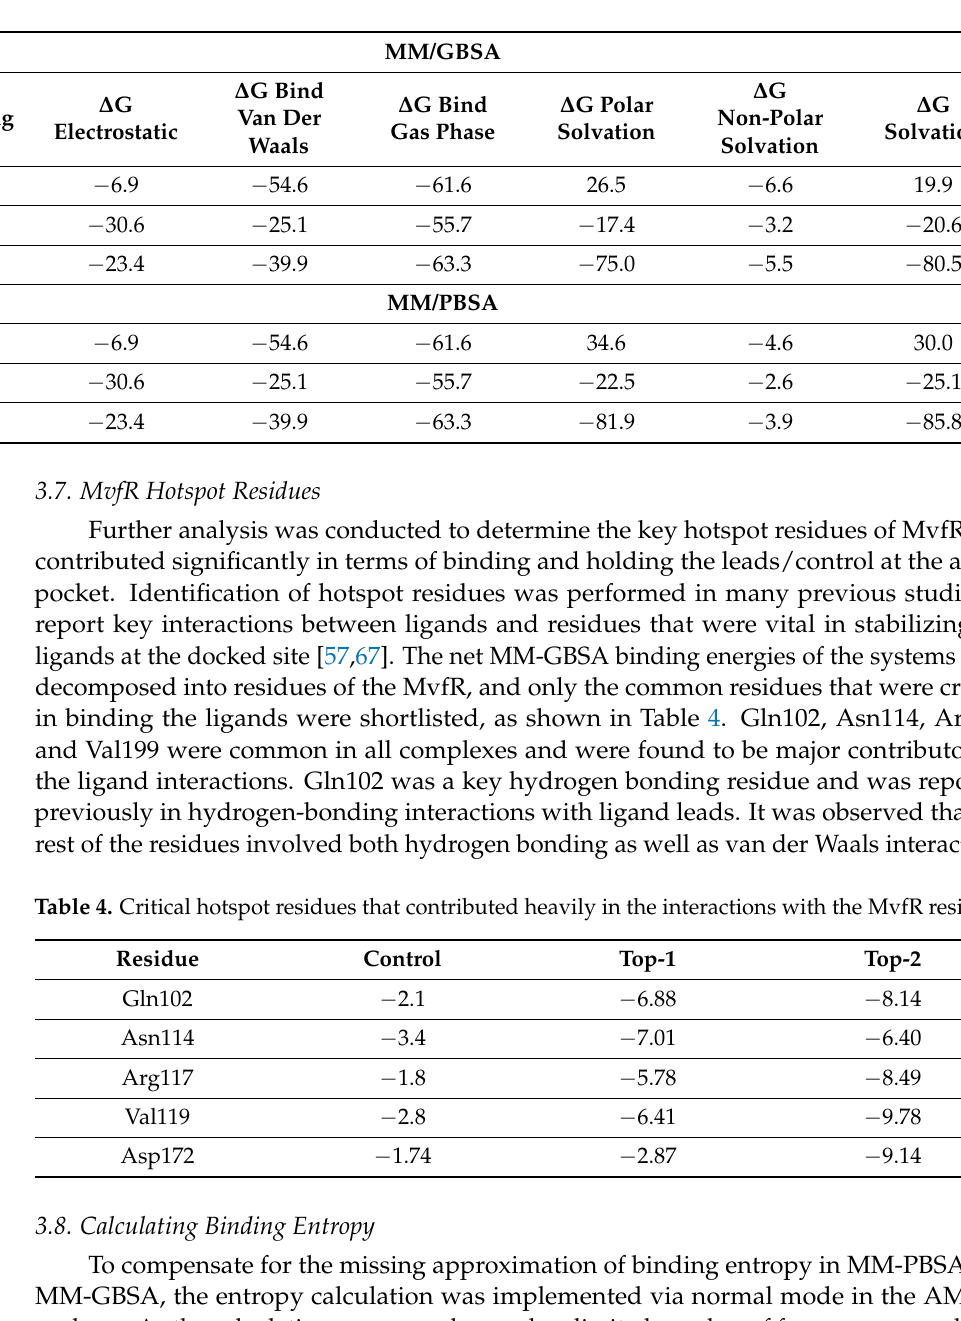
Table 3. Estimated net binding energies (in kcal/mol) of complexes at different time steps of molecular dynamics simulation